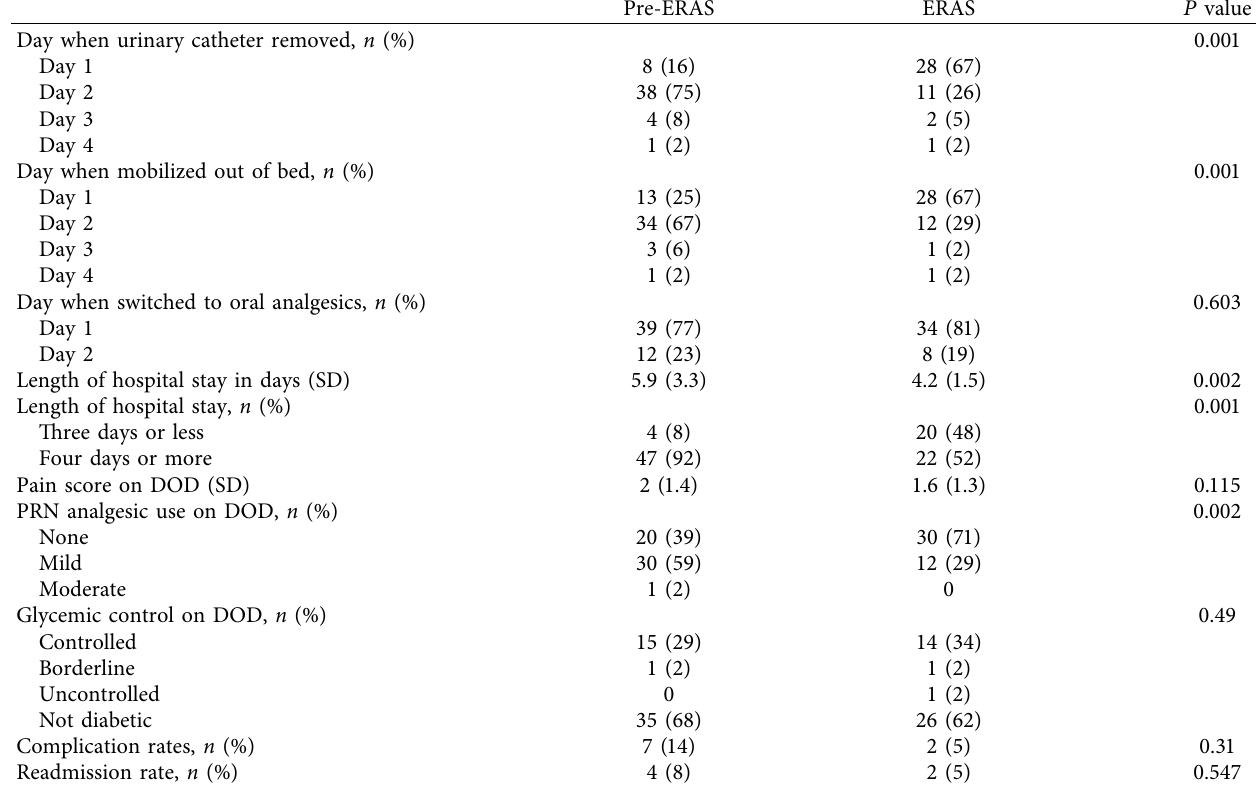
Table 4: Postoperative data in both groups with P